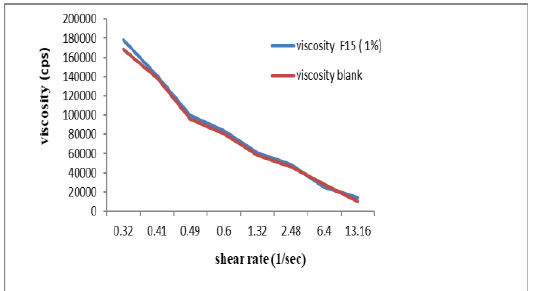
Figure 9.Viscosity versus shear rate for gelled F15 and the blank hydrogel.